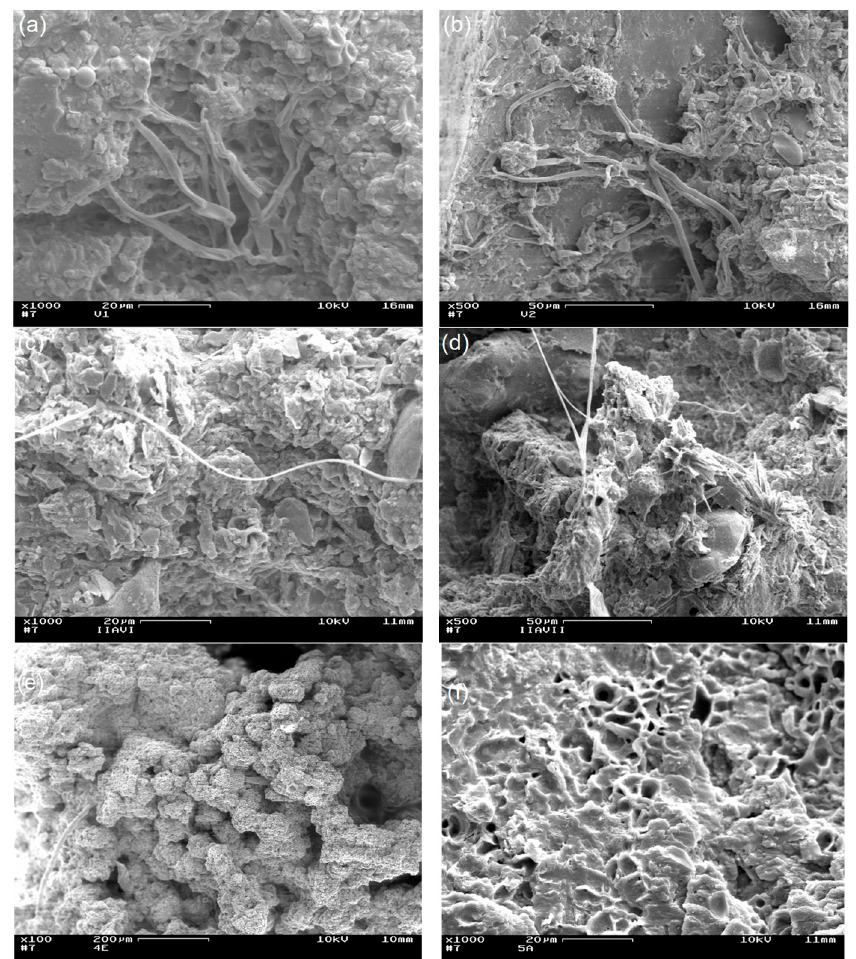
Figure 7. SEM micrographs of PUs subjected to soil degradation: ( a ) PULOA and ( b ) PULOB, 40 days; ( c ) PULOA and ( d ) PULOB, 80 days; ( e ) PULOA and ( f ) PULOB, 120 days.